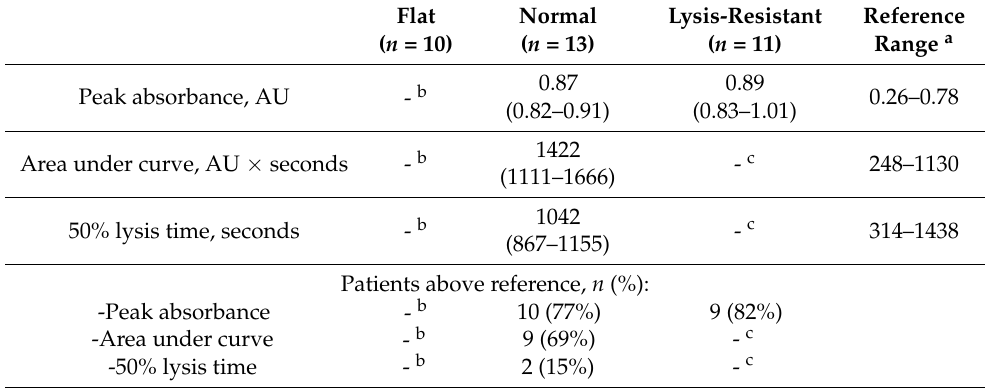
Table 2. Fibrin formation and lysis variables in patients with flat, normal and lysis-resistant fibrin formation curves on day 1. Medians with interquartile ranges are reported.